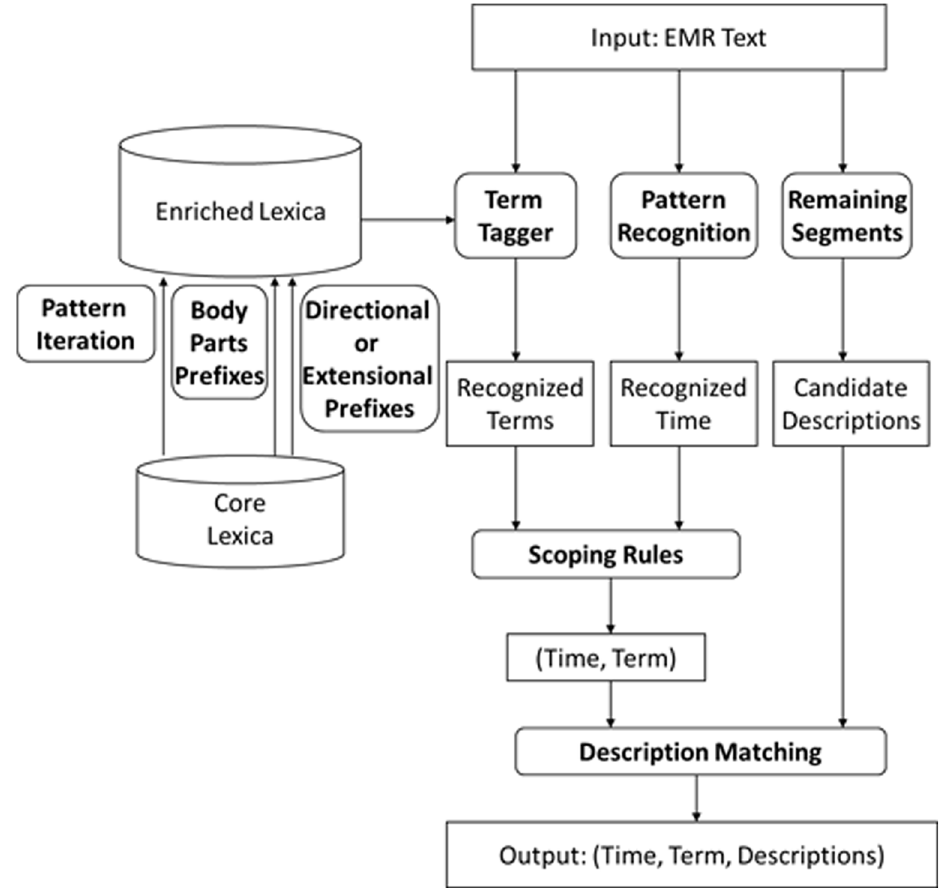
Fig 3. Chinese EMR information extraction system